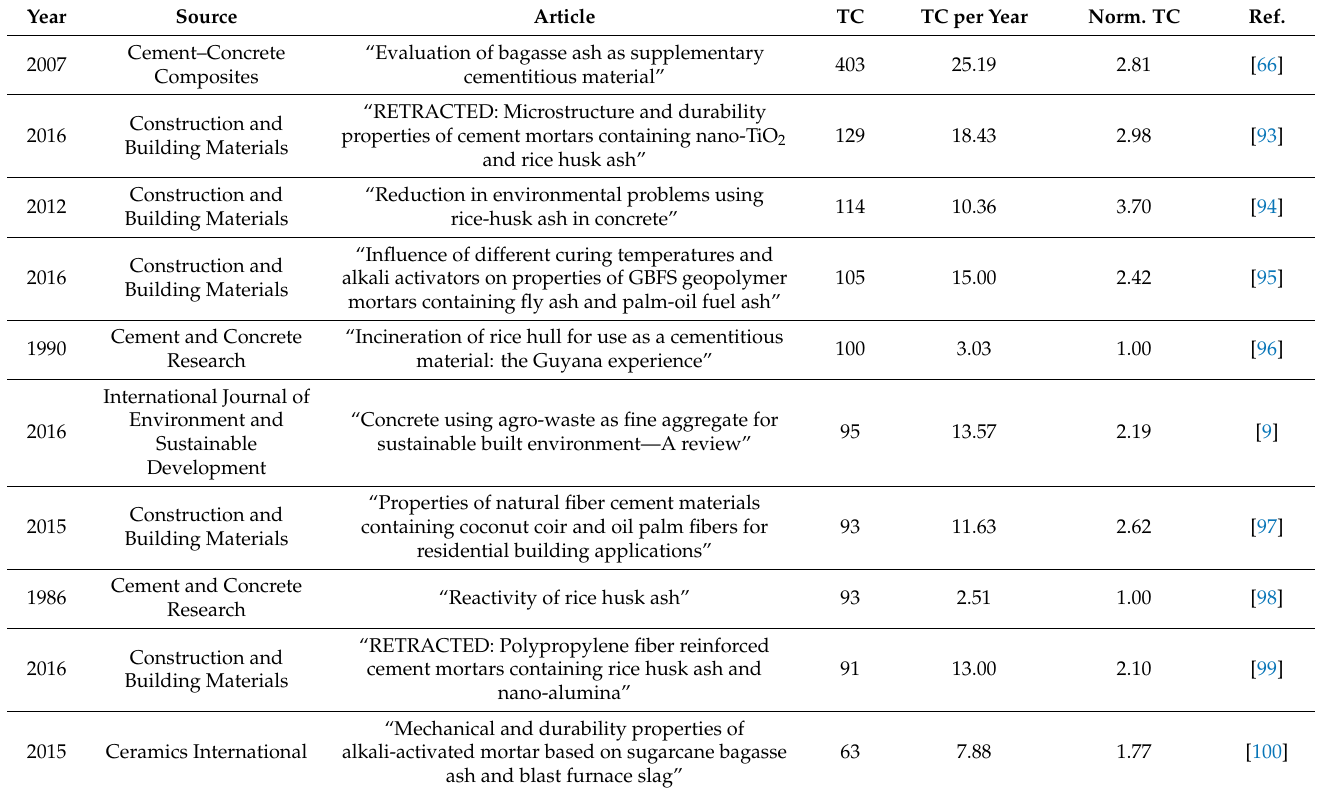
Table 8. Top 10 most globally cited